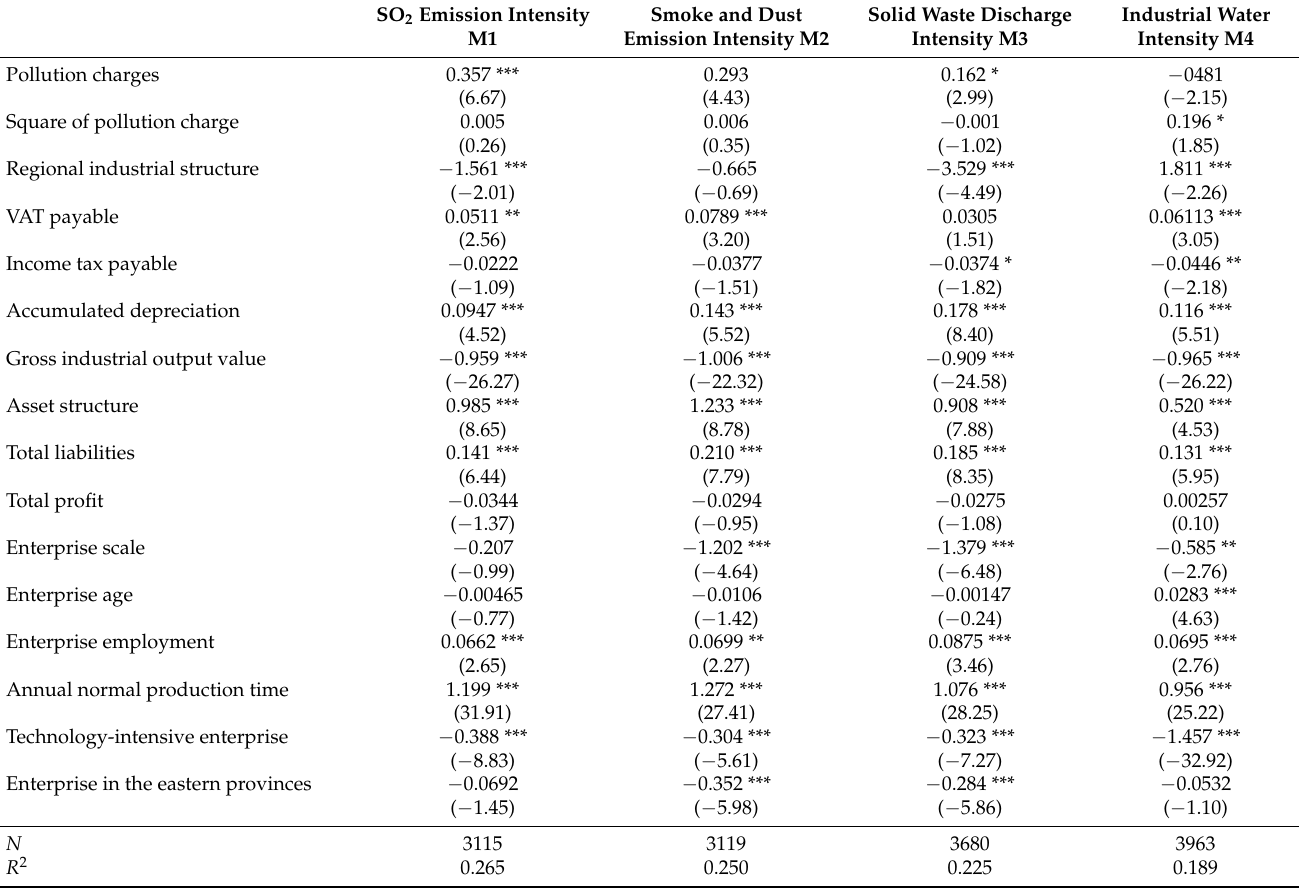
Table 3. Regression results of the impact of pollution charges on enterprises’ process improvement and technological innovation in